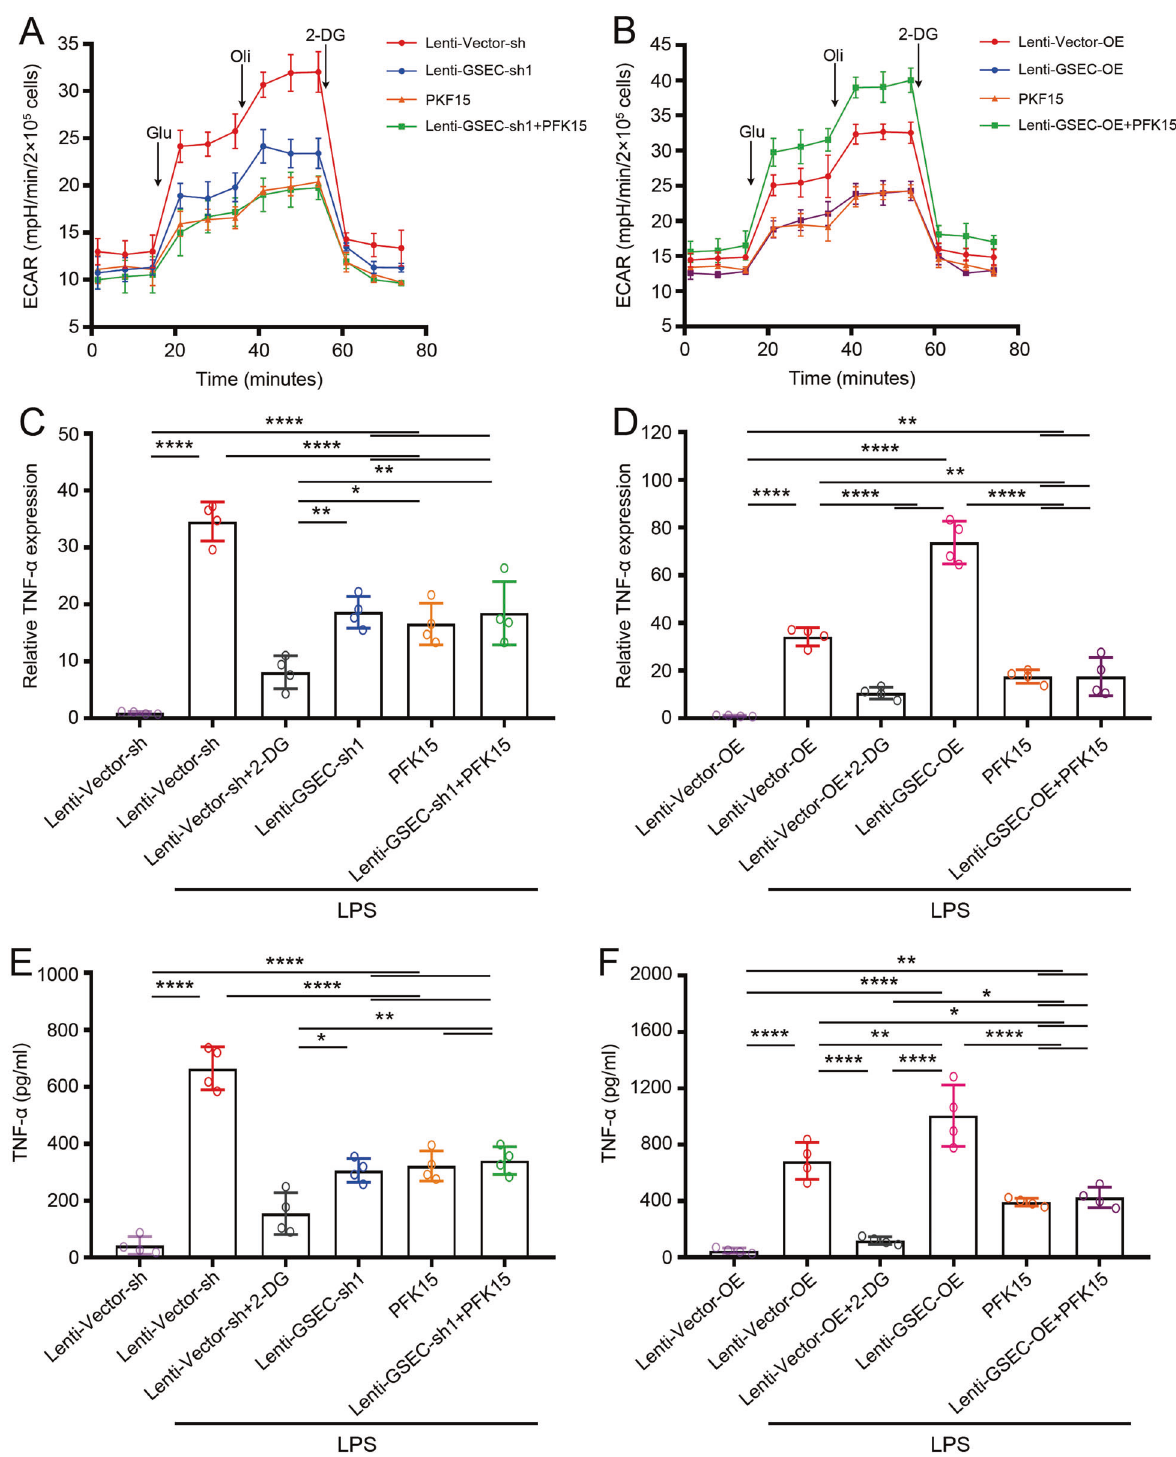
Fig. 6 GSEC/PFKFB3-supported glycolytic metabolism enhances dHL-60 cell in fl ammatory factor expression. A The ECAR was detected in GSEC-knockdown dHL-60 cells. B The ECAR was detected in GSEC-overexpressing dHL-60 cells. C The level of TNF- α mRNA expression was detected in GSEC-knockdown dHL-60 cells. D The level of TNF- α mRNA expression was detected in GSEC-overexpressing dHL-60 cells. E The level of TNF- α protein was detected in GSEC-knockdown dHL-60 cells. F The level of TNF- α protein was detected in GSEC-overexpressing dHL- 60 cells. For all experiments: n = 4 per group, three independent experiments. Neutrophils and dHL-60 cells were treated LPS for 12 h. * P < 0.05, ** P < 0.01, *** P < 0.001, *** P < 0.0001, ns P indicates no statistical signi fi cance. Glu, glucose; Oli, oligomycin; 2-DG, 2-deoxyglucose.